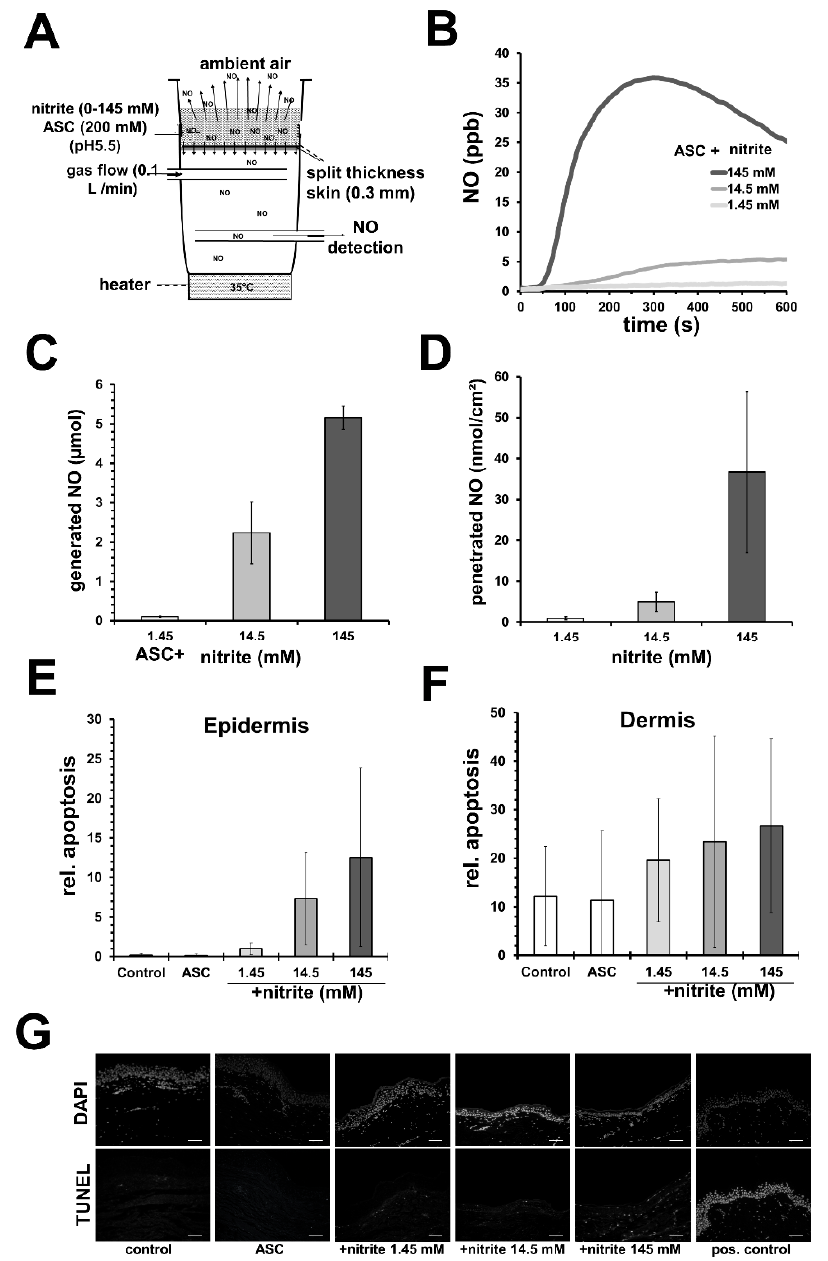
Figure 2. Nitric oxide – releasing solutions can induce apoptosis in human skin. ( A ) Experimental set-up to measure nitric oxide (NO) penetration through human split skin. ( B ) Exemplary registration of measured NO below skin with sodium ascorbate (ASC; 100 mM)-containing acetate buffer (pH 5.5) and nitrite in concentration as indicated. ( C ) Shows the amount of generated NO from 1 mL of the nitrite solution (described in ( B ) in 600 s). ( D ) By integration the amounts of penetrated NO were calculated. Shown are the mean values ± SD of 3 independent experiments using different skin specimens. ( E ) Different nitrite/ascorbate buffers were applied on vital human skin samples and apoptosis was detected 24 h later by TUNEL assay. Shown are the mean values ± SD ( n = 3) of relative apoptosis, the counted number of TUNEL-positive cells in relation to the total number (DAPI-stained) of cells found in the epidermis or ( F ) dermis. ( G ) Exemplary fluorescence microscope images obtained from skin samples treated as indicated (white bar = 100 µm).